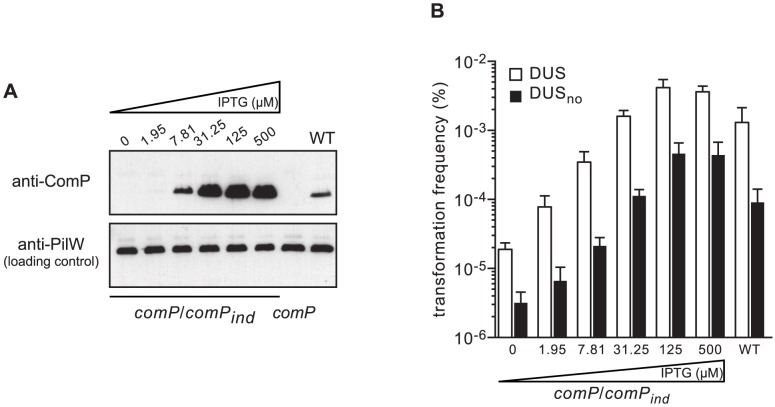
ComP controls transformation both in the presence and in the absence of DUS.(A) Immunoblot analysis of ComP production (upper panel) in strain comP/comPind in the presence of increasing concentrations of IPTG. Strain comP/comPind is a comP mutant complemented by an ectopic WT copy of comP under the control of an IPTG-inducible promoter. The WT strain was included as a control. Equal amounts of whole-cell protein extracts were loaded in each lane, which was confirmed by detecting PilW (lower panel). (B) Quantification of competence for DNA transformation in strain comP/comPind in the presence of increasing concentrations of IPTG using ΔpilN PCR fragments obtained with primers containing the canonical DUS (white bars), or no DUS (black bars). The WT strain was included as a control. Results are expressed as percentages of recipient cells transformed, and are the mean ± standard deviation of four to six independent experiments.